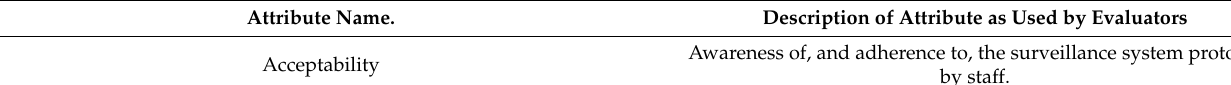
Table 3. Attributes identified and their definitions.